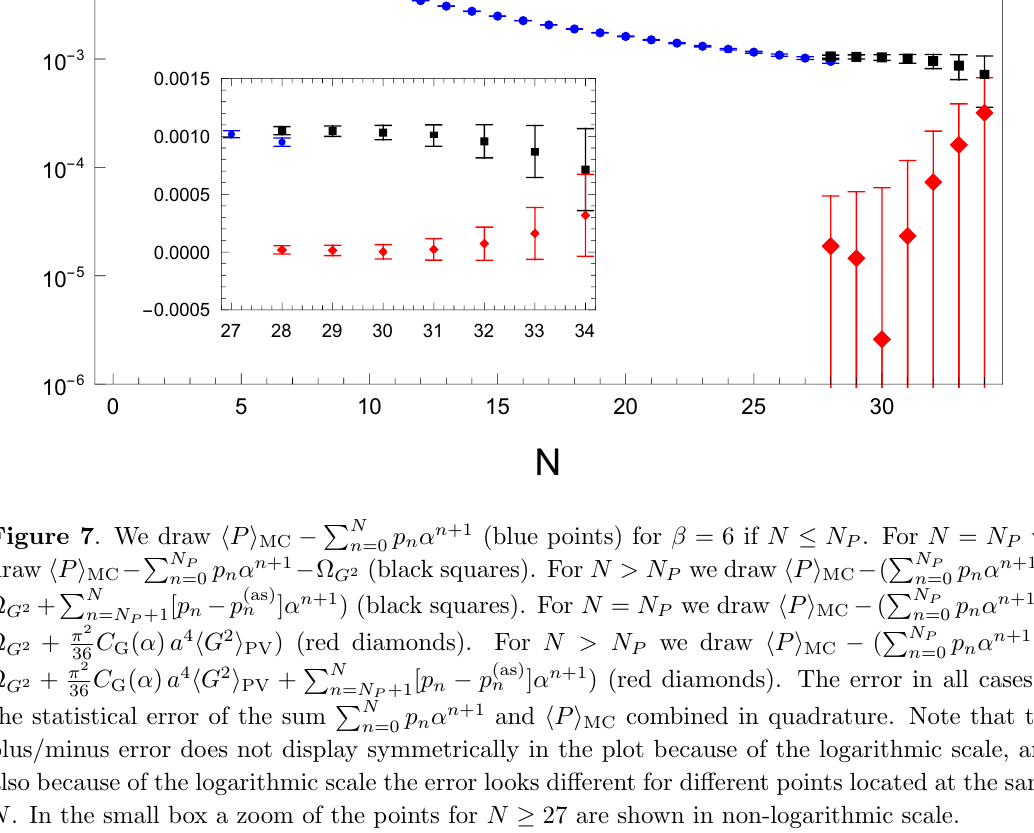
p n (cid:11) n +1 (blue points) for (cid:12) = 6 if N (cid:20) N P . For N = N P n =0